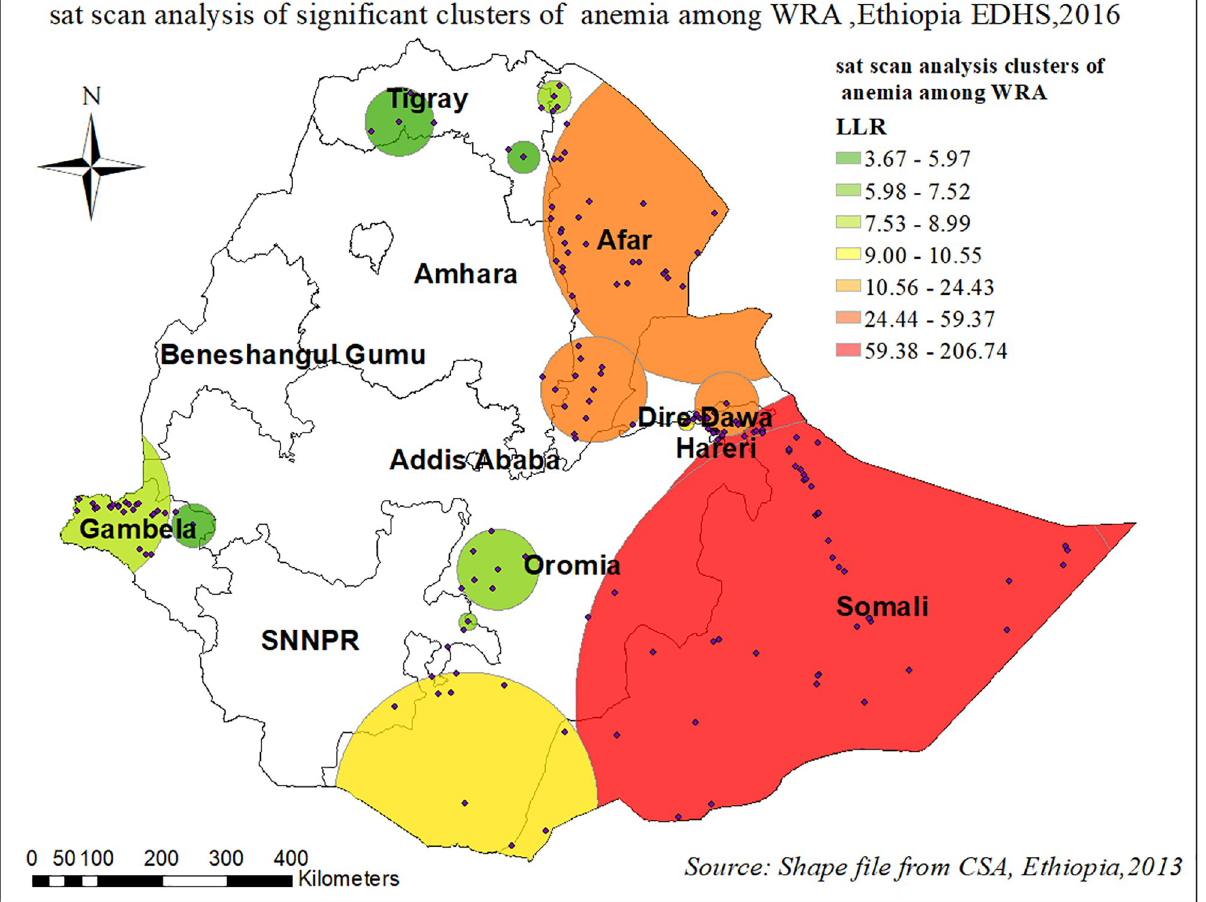
Fig 8. Sat scan analysis of significant clusters of anemia among reproductive age women in Ethiopia, EDHS 2016.